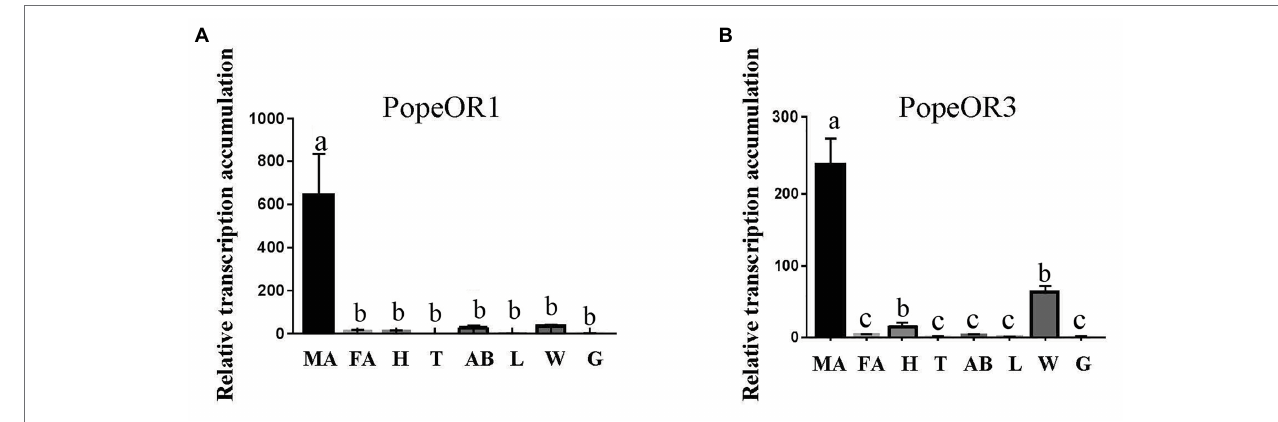
FIGURE 3 | Expression profiles of PopeOR1 (A) and PopeOR3 (B) genes in different tissues. MA, male antennae; FA, female antennae; H, heads (without antennae); T, thoraxes; AB, abdomens; L, legs; W, wings, G, genitalia. Error bars indicate standard error of three biological replicates. Different letters within the same figure mean that the values are significantly different under one-way ANOVA followed by Tukey’s honest significant differences (HSD) test ( p <